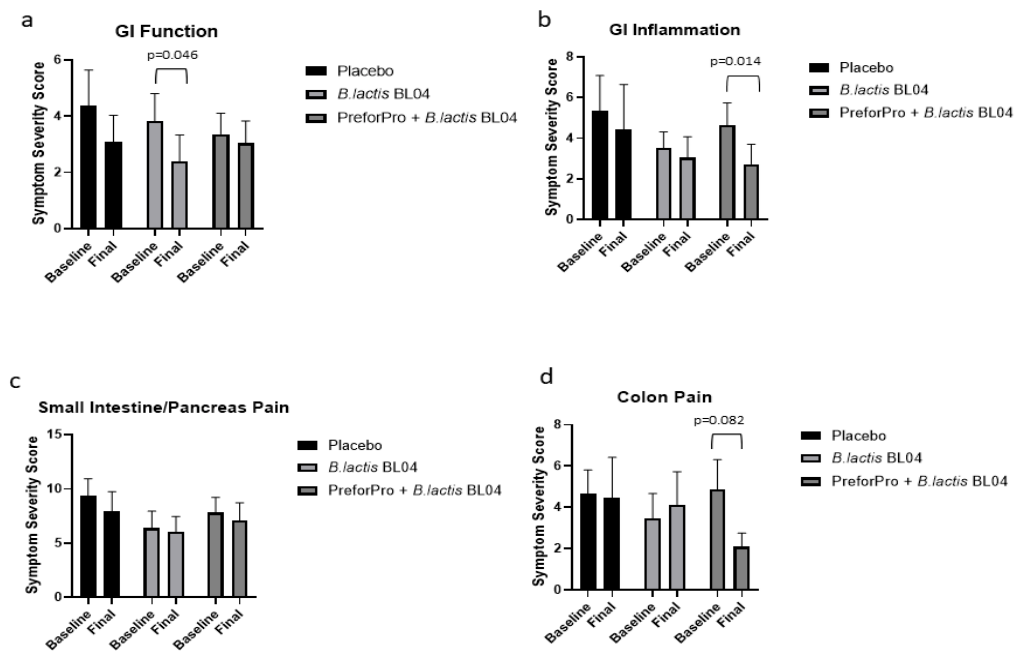
Figure 2. Average symptom severity before and after treatment as determined by gastrointestinal (GI) questionnaire. Average scores at baseline and after 4-weeks are shown for functional assessments of ( a ) Gastrointestinal function; ( b ) gastrointestinal inflammation; ( c ) small intestine pain; and ( d ) colon pain.